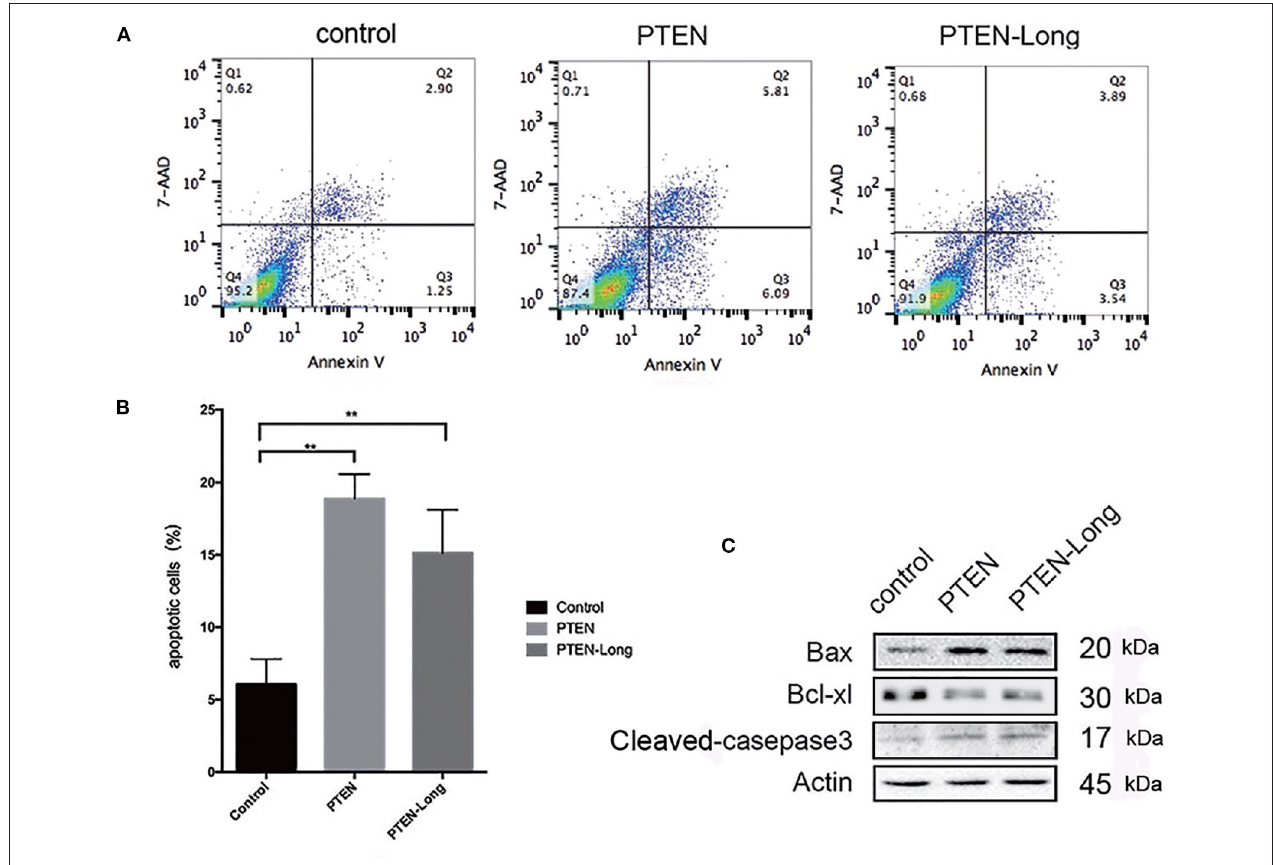
FIGURE 4 | PTEN-Long induces apoptosis of HepG2 cells. (A) Flow cytometric analysis of apoptosis. (B) The proportion of apoptotic cells (Annexin V + , 7-ADD-) calculated using FlowJo (** P < 0.01). (C) Western blot analysis of apoptosis-related proteins in HepG2 cells.